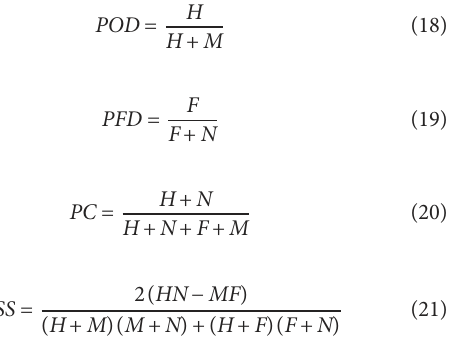
Table 2 summarizes the validation metric scores for each model when tested with the storms mentioned above. The missing values in the table are due to no occurrences of the observed and predicted dB / dt crossing the higher thresholds. H The overall POD and HSS values show that the models have a better performance with the 2015 storm than with the 2011 storm. This is consistent with the findings from the